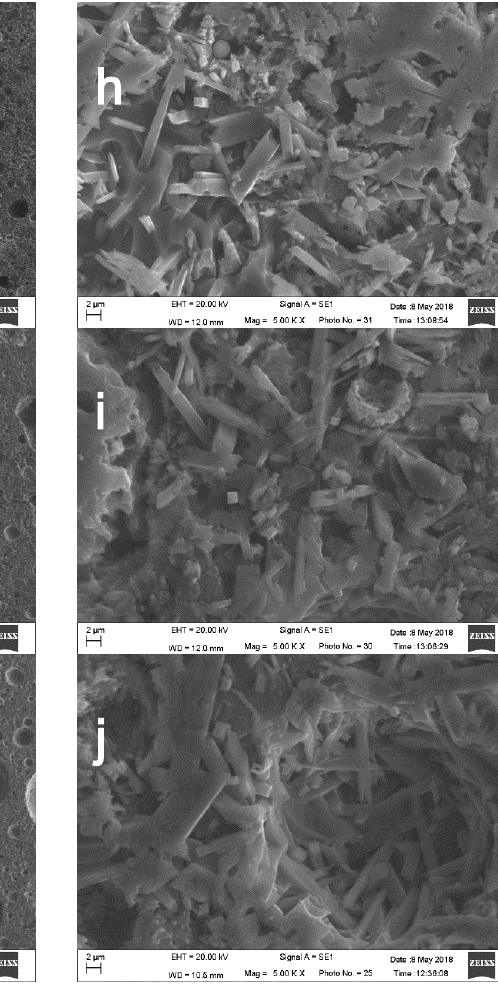
Figure 5. SEM micrographs of samples at the optimum sintering temperature: ( a , f ) sample 1; ( b , g ) sample 2; ( c , h ) sample 3; ( d , i ), sample 4; and ( e , j ) sample 5.